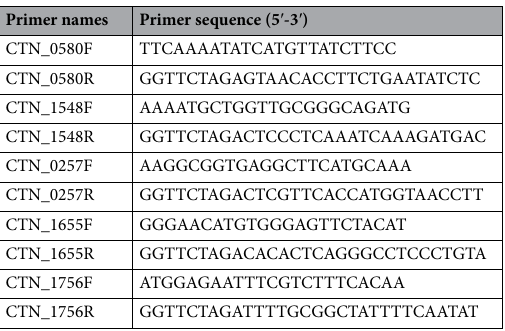
Table 1. Primer sequence used in PCR amplification of genomic